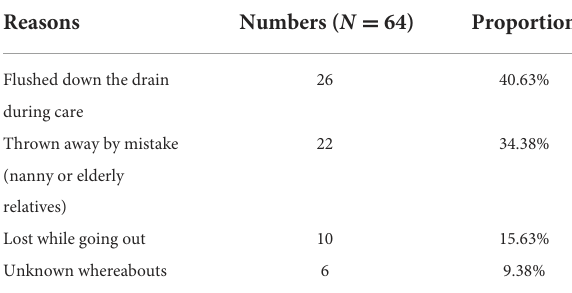
TABLE 1 Causes of OK lens fragmentation. TABLE 2 The causes of OK lens